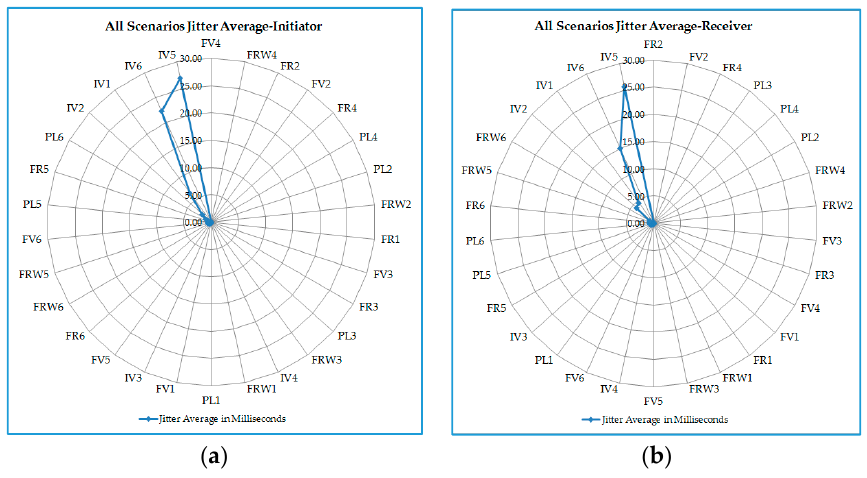
Figure 16. All scenarios’ end-to-end average delay comparison for: ( a ) VoIP initiators; ( b ) VoIP receivers.